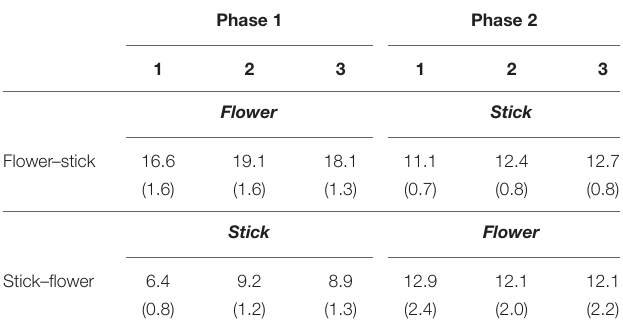
TABLE 4 | Mean times (s) required for placing each piece of material during the second half of SFA